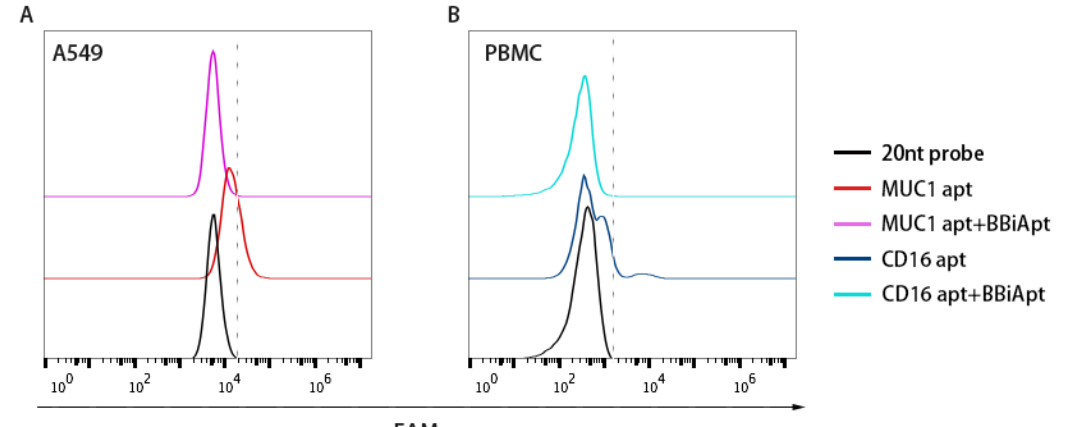
Figure 4. The bindings of monovalent aptamers to MUC1-positive A549 cells ( A ) or CD16-positive PBMCs ( B ) in the presence or absence of BBiApt. Red line represented A549 cells treated with FAM-labeled MUC1 aptamer. Purple line represented A549 cells treated with both FAM-labeled MUC1 aptamer and BBiApt. Dark blue line represented PBMCs treated with FAM-labeled CD16 aptamer. Light blue line represented PBMCs treated with both FAM-labeled CD16 aptamer and BBiApt. Black line represented cells treated with a FAM-labeled 20 nt DNA which served as a background control.